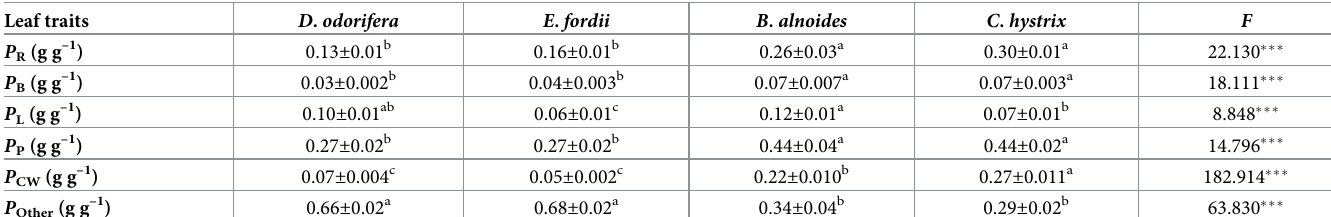
Table 5. Fraction of leaf N allocated to rubisco ( P R ), bioenergetics ( P B ), light-harvesting components ( P L ), photosynthetic apparatus ( P P ), cell wall ( P CW ), and other parts (1- P P - P CW , P Other ) in four species seedling